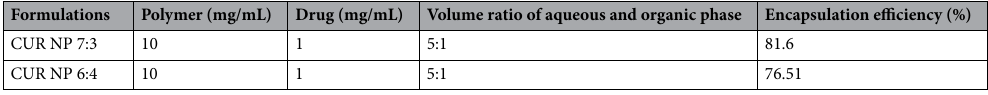
Table 1. Represents the encapsulation efficiency of CUR NP 7:3 and CUR NP 6:4.